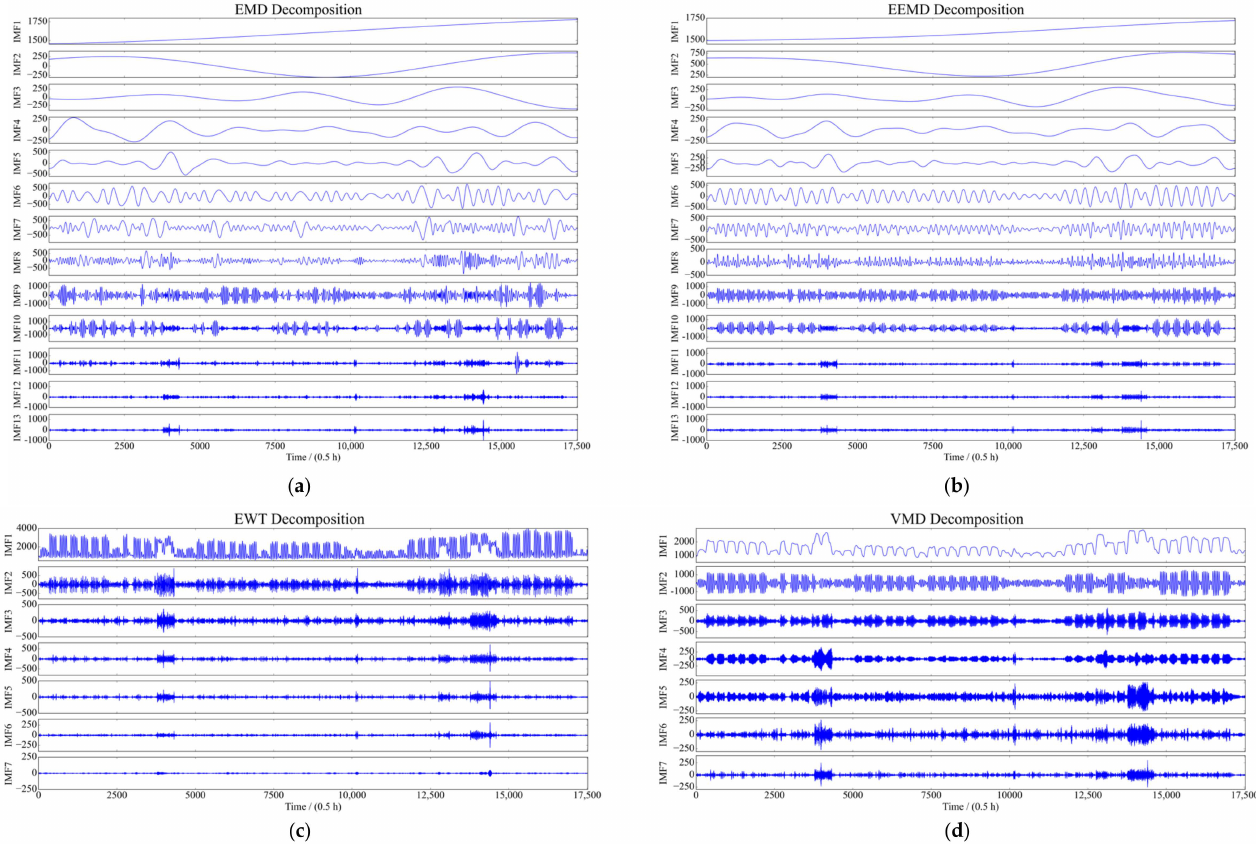
Figure 9. Decomposition results of building power consumption data with different decomposi- tion algorithms.